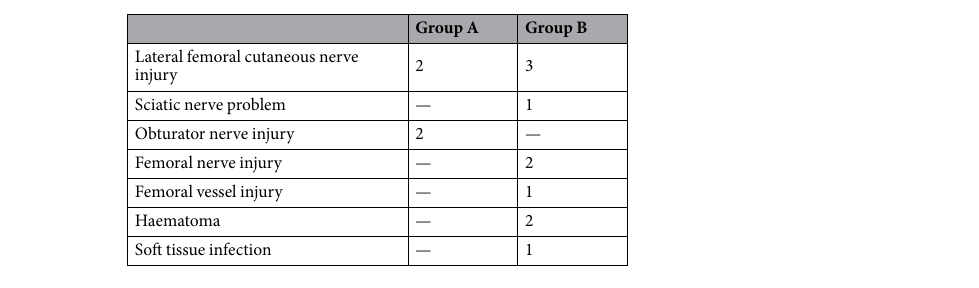
Table 2. Postoperative complications of the two groups were